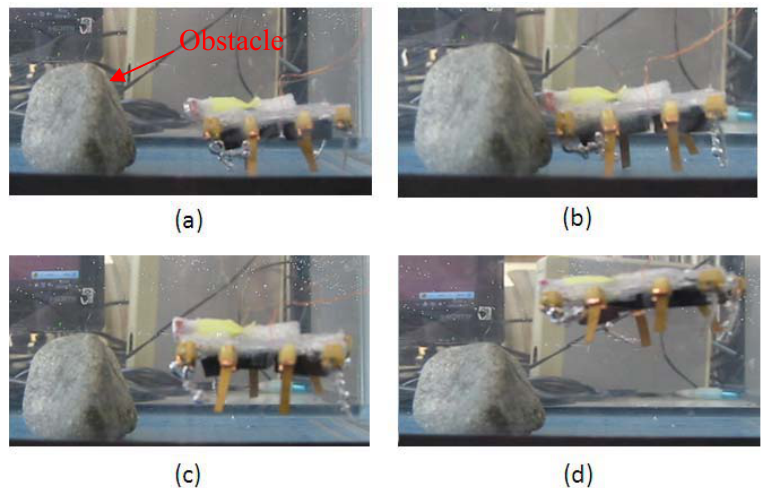
Figure 28. Obstacle avoidance experiment.